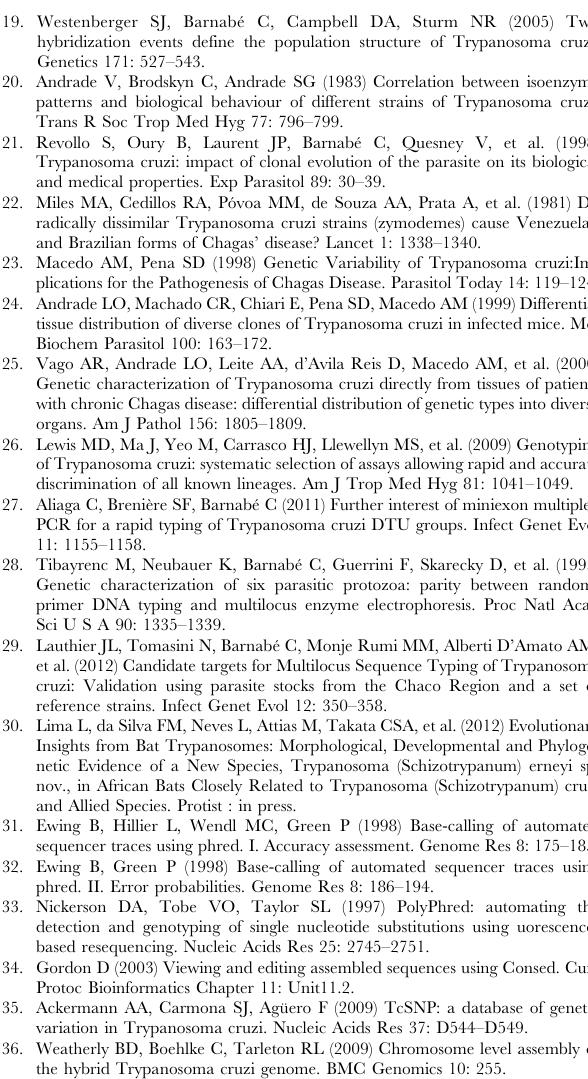
Figure S1 Multiple sequence alignment of TcSC5D sequences. Thirty three (33) sequences were obtained by re-sequencing of the TcSC5D locus in T. cruzi (different DTUs) and T. cruzi marinkellei . The actual sequence is shown only for the first strain (Sylvio X10). For the rest of the sequences, only nucleotides differing from the top sequence are shown. Putative homoplasic traits (enclosed in red boxes), correspond to those sites where a strain deviates from the expected character state for its current DTU/lineage classification. Key informative polymorphic sites (see Figure 1) are enclosed in blue boxes. Polymorphic restriction enzyme sites are also boxed, with solid lines (homozygous) or dotted lines (heterozygous). Ambiguities (heterozygous characters) are denoted using standard IUPAC notation.